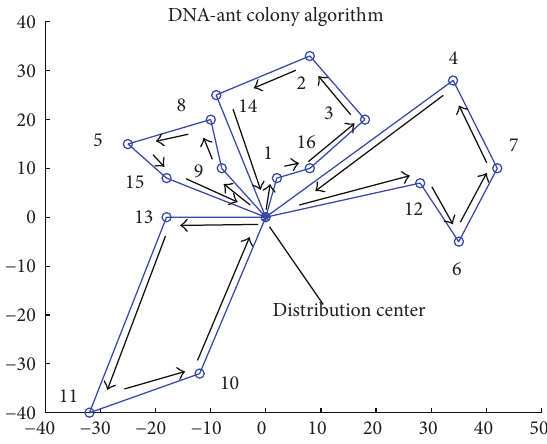
Figure6:DistributionpathDNA-antcolonyalgorithm(toporgood air pollution level).